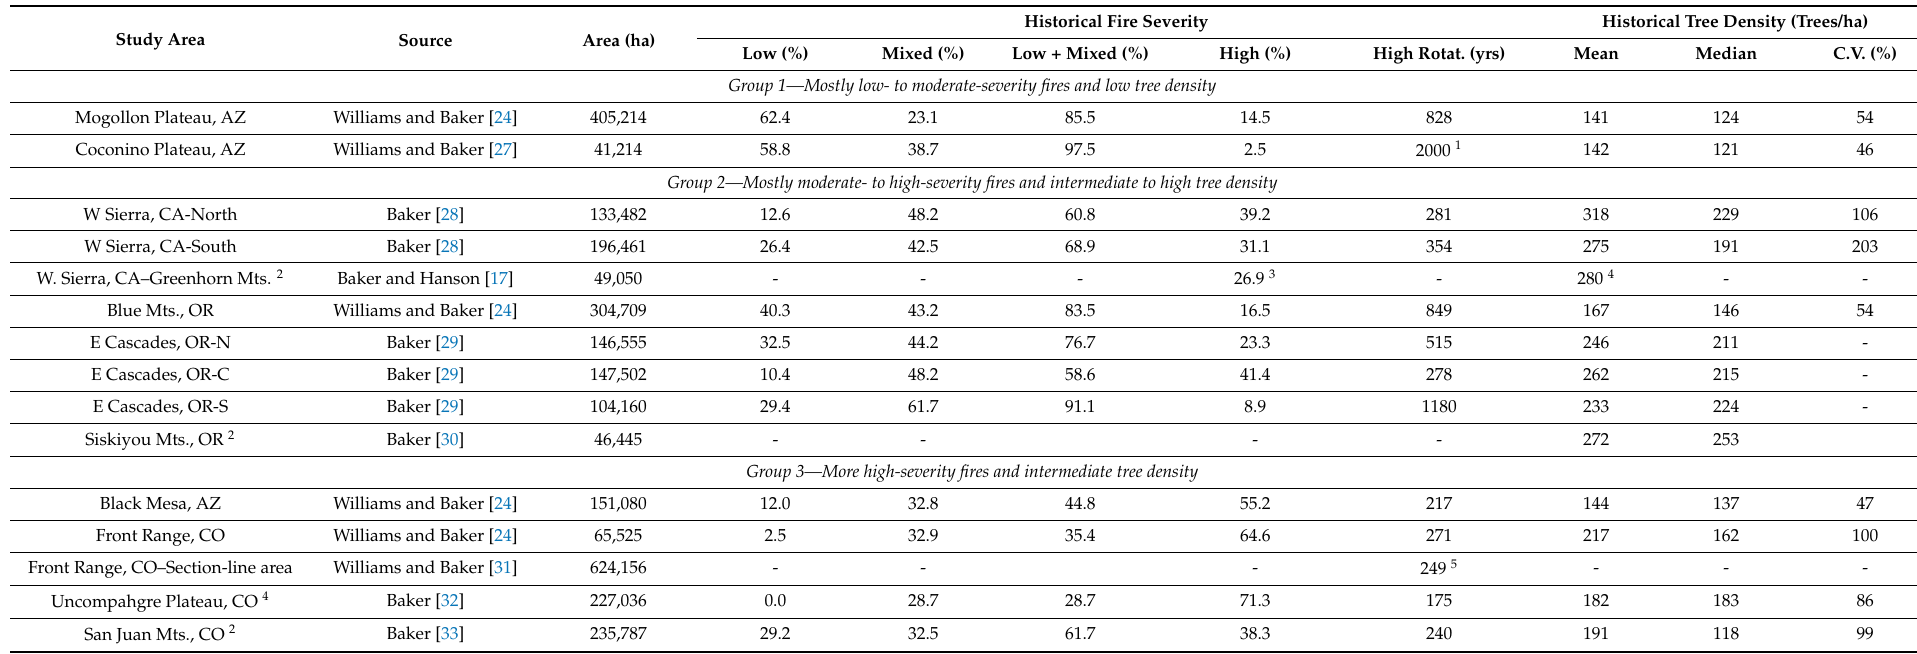
Table 1. The 15 dry-forest landscapes with reconstructions from US General Land Office survey data based on WB